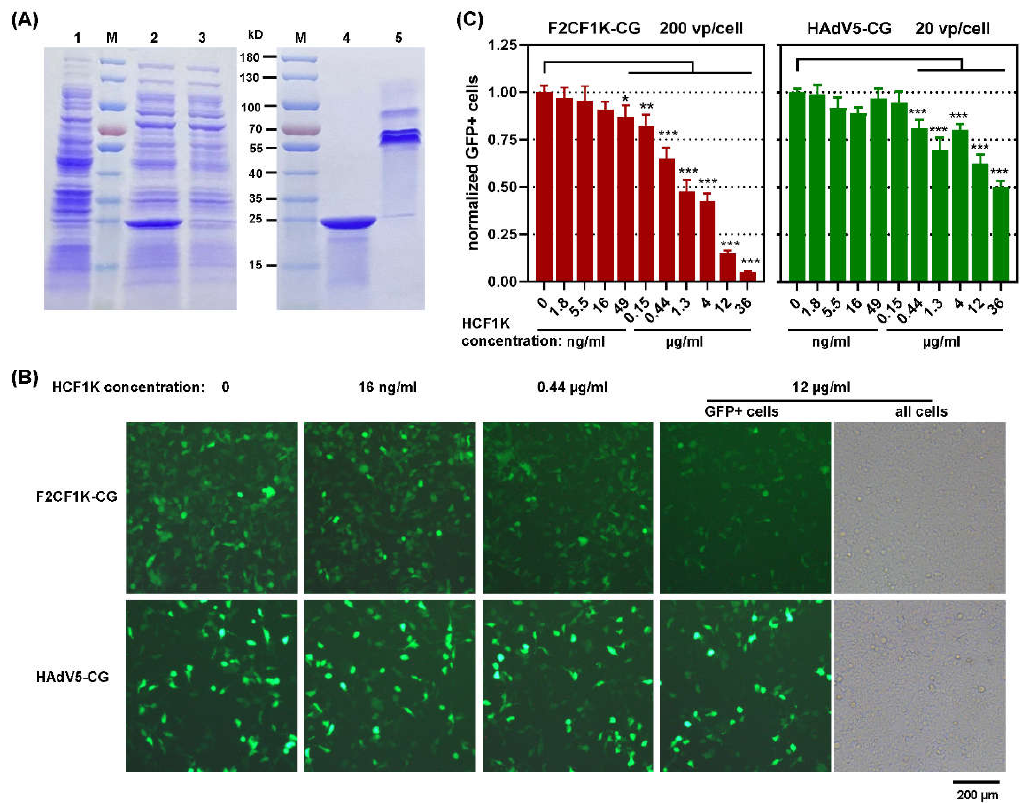
Figure 4. Block the infection of F2CF1K-CG or HAdV5-CG to 293 cells with recombinant